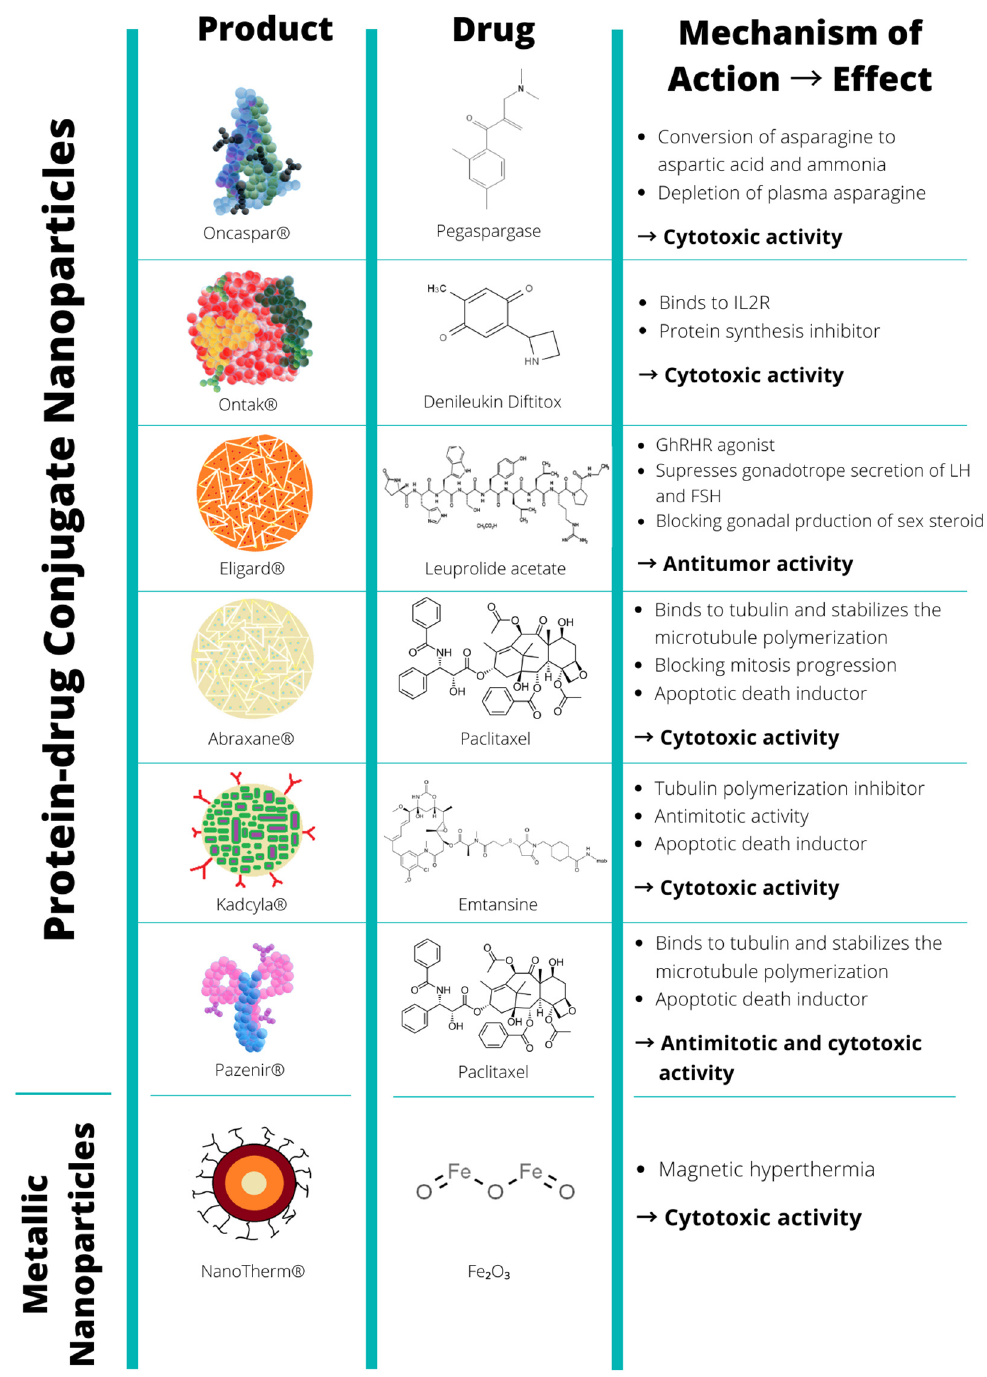
Figure 2. Protein- and metallic-based approved and marketed nanopharmaceuticals. FDA and/or EMA-approved nanomedicines from 1995 to 2022 (last accessed May 2022), cataloged by their nature, encapsulated drug, their mechanism of action, and their induced effects.